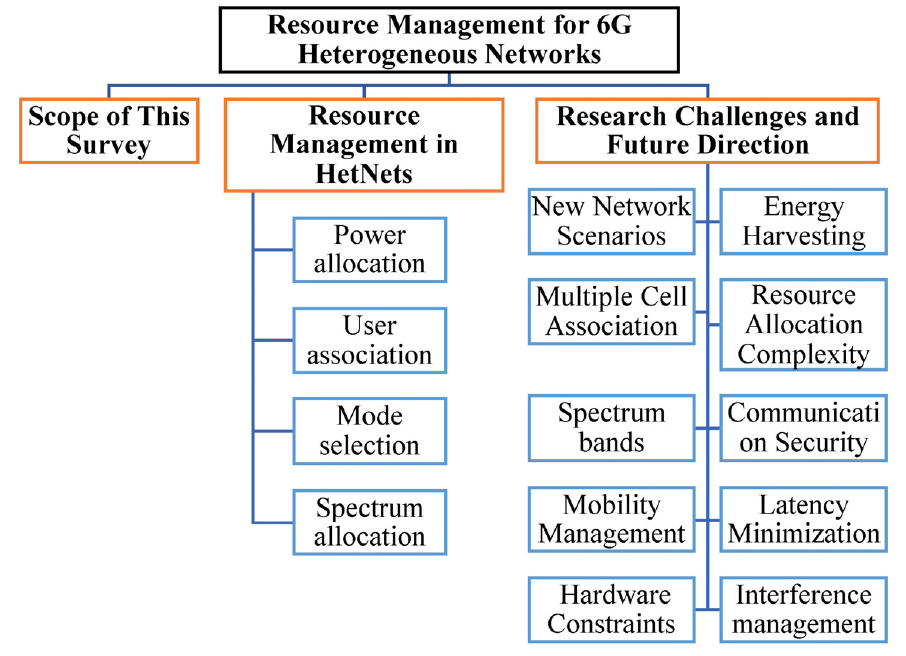
Figure 3. Organization of this study.